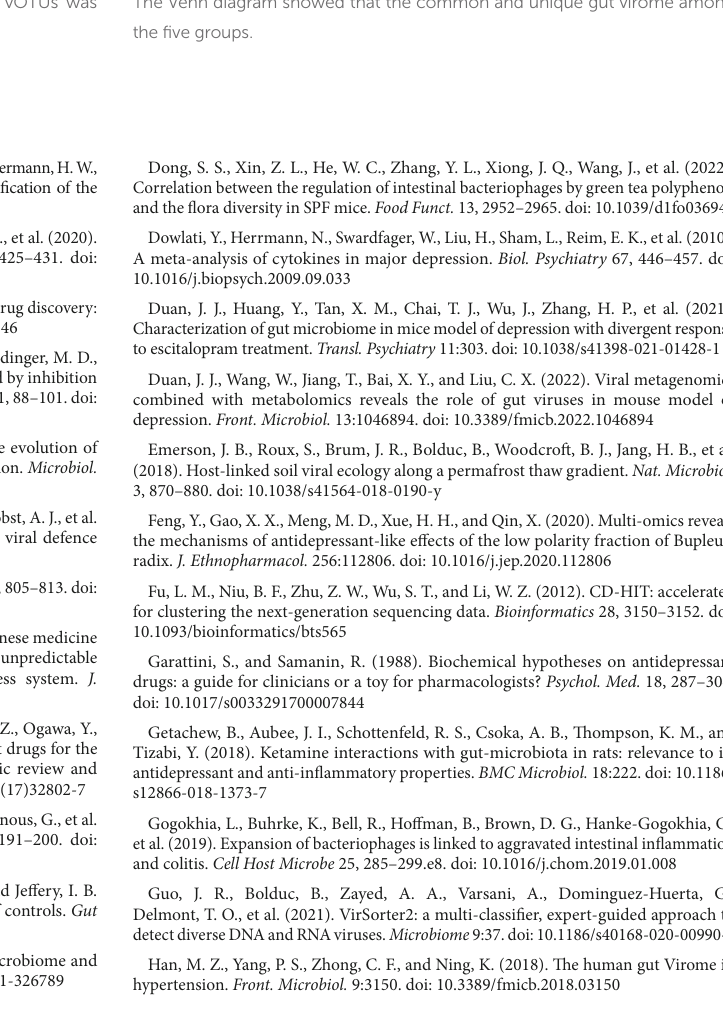
The two bioinformatics methods to screen and identify virus sequences is shown.